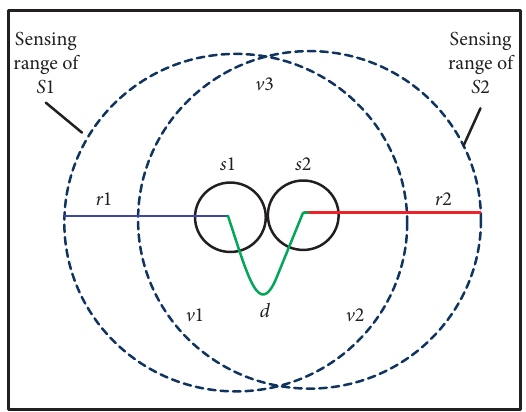
Figure 3: Shared area between two adjacent